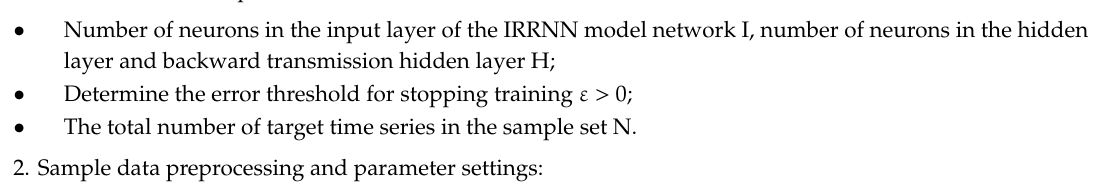
Algorithm 1 Training process of time series classification algorithm based on